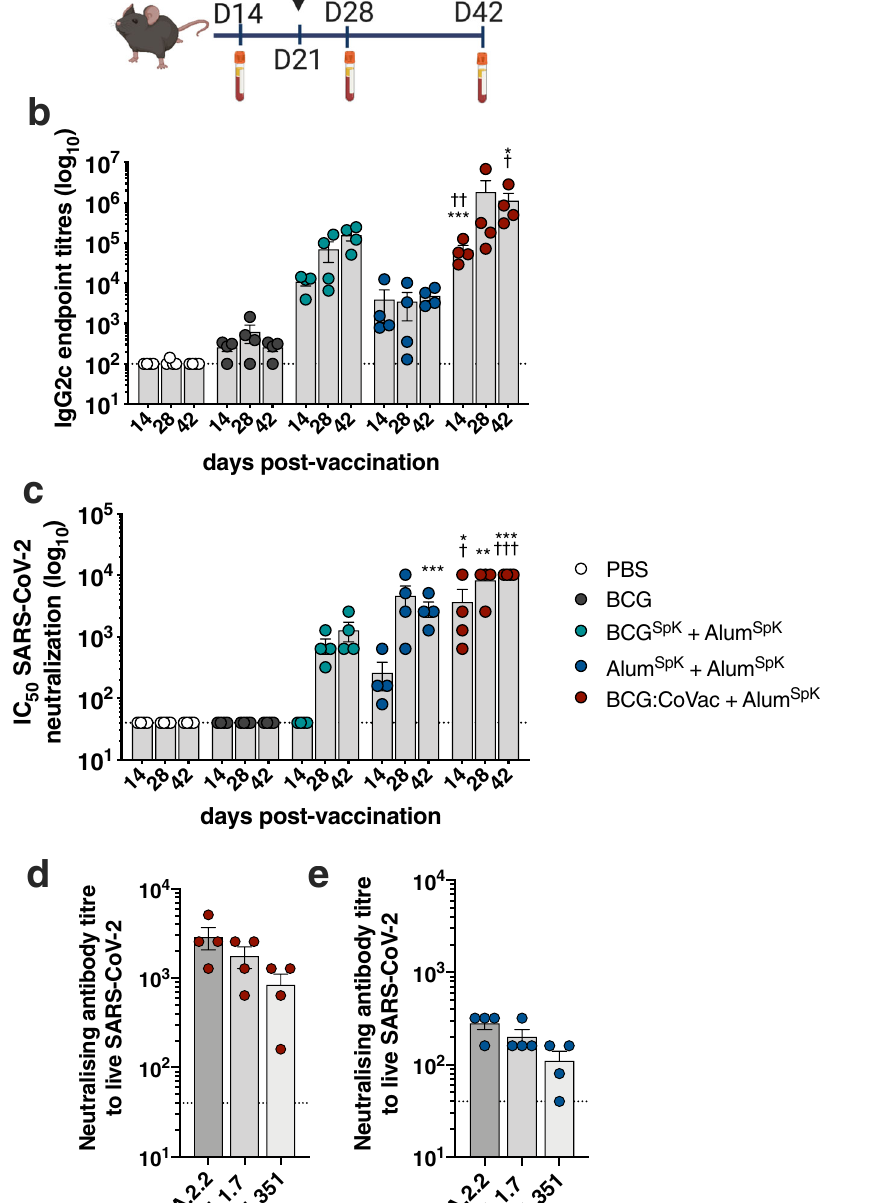
Fig. 5 Heterologous boosting of BCG:CoVac-primed mice results in augmented SARS-CoV-2-speci fi c IgG2c titres and neutralising antibodies. a C57BL/6 mice ( n = 3 – 4/group) were vaccinated (as in Fig. 1) and at day 21 mice were boosted with Alum Spk . b Spike-speci fi c IgG2c titres in plasma were determined by ELISA estimated from the sigmoidal curve of each sample interpolated with the threshold of the negative sample ±3 standard deviations. c Neutralising antibody (NAb) titres (IC 50 ) were calculated as the highest dilution of plasma for all groups that still retained at least 50% inhibition of infection compared to controls. The dotted line shows the limit of detection. d , e NAb titres against the B.1.1.7 or B.1.351 SARS-CoV-2 variants were also determined using plasma from either d Alum SpK or e BCG:CoVac-vaccinated mice. Data presented as mean ± SEM and is representative of two independent experiments. Signi fi cant differences between groups compared to BCG Spk * p < 0.05, ** p < 0.01, *** p < 0.01 or Alum Spk † p < 0.05, †† p < 0.01, ††† p < 0.001 were determined by one-way